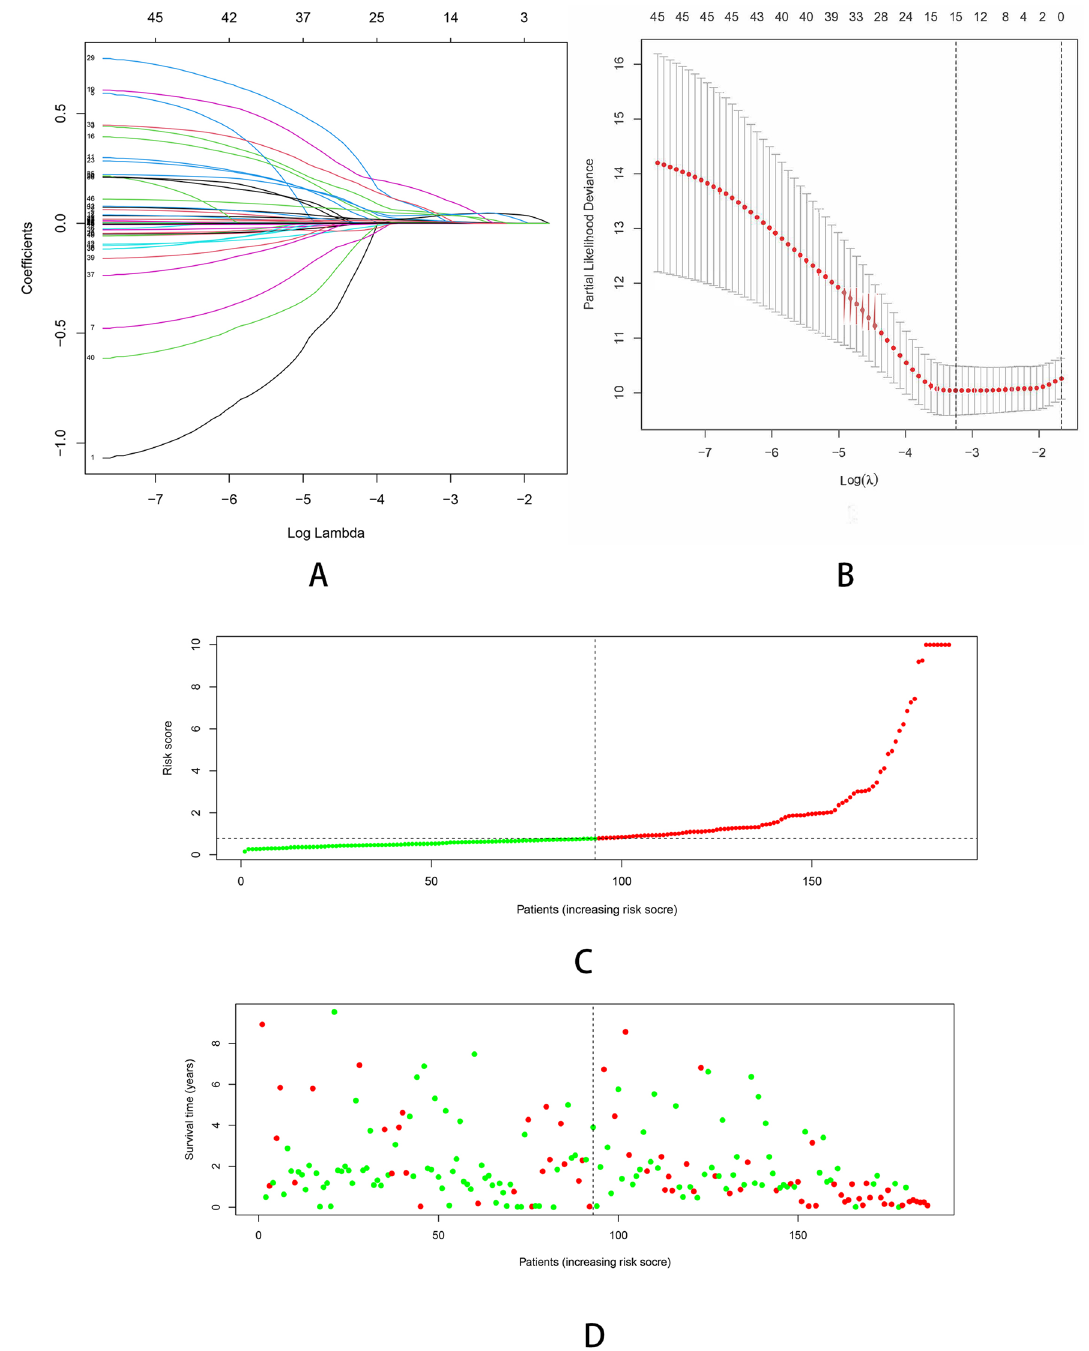
Figure 3. Construction of the immune-related prognostic signature in HCC. (A) Lasso regression analysis to eliminate collinearity. (B) Partial likelihood deviance for different numbers of variables. (C) The distribution of risk score. (D) The survival status and duration of